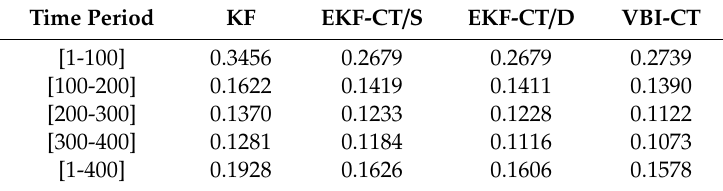
Table 1. Comparison of tracking error of di ff erent algorithms with σ 2 = 0.1.